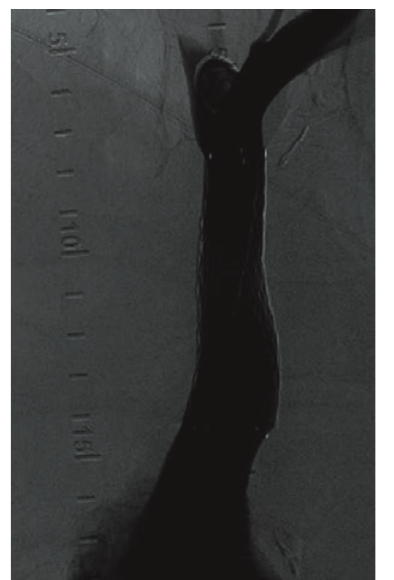
Fig. 2. Superior vena cava at the time of stent deployment.